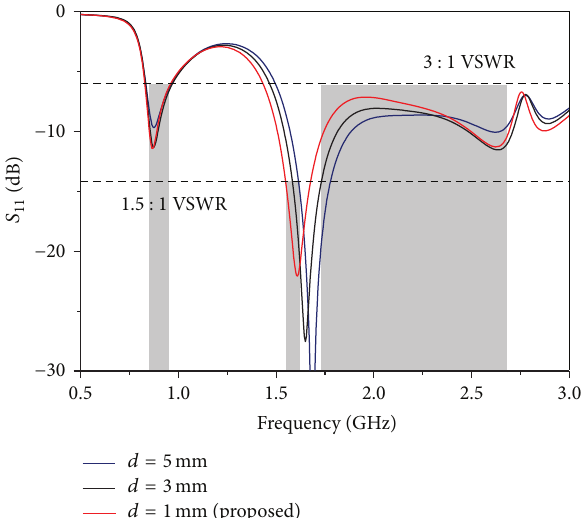
Figure 5: The influence of the distance 𝑑 (between the feed point A and shorted point B) on the simulation 𝑆 11 result.